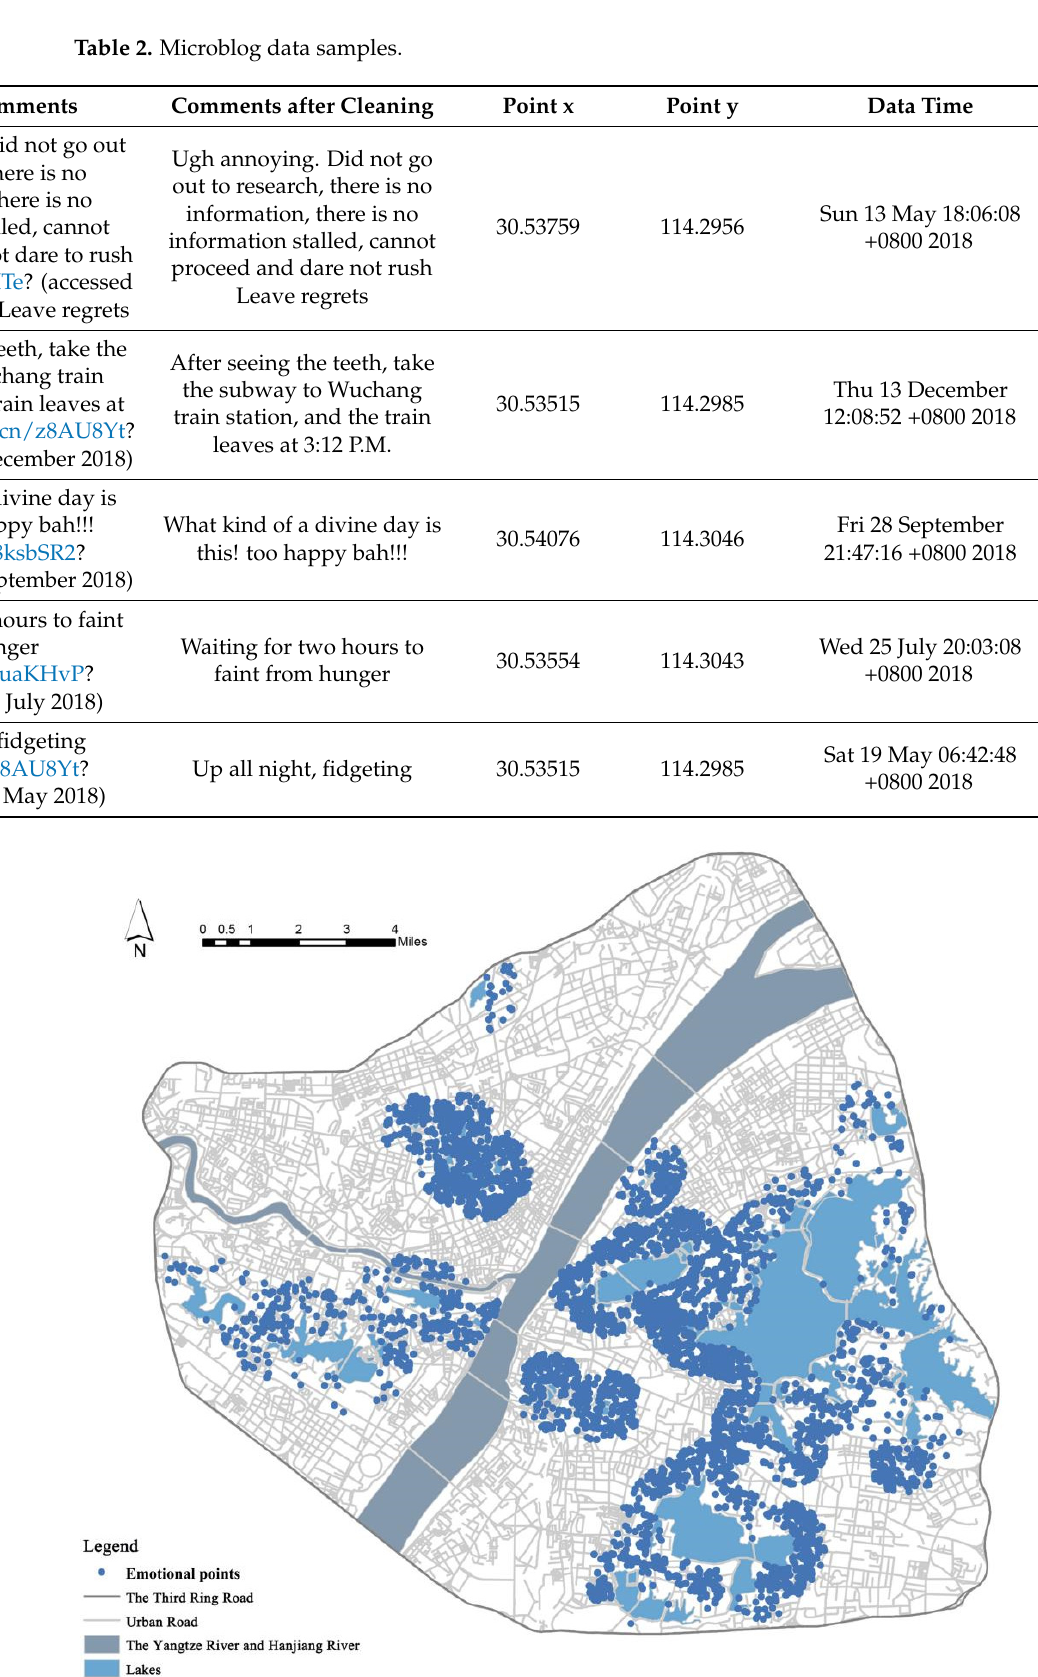
Figure 3. Distribution of emotional points in the lakefront area.